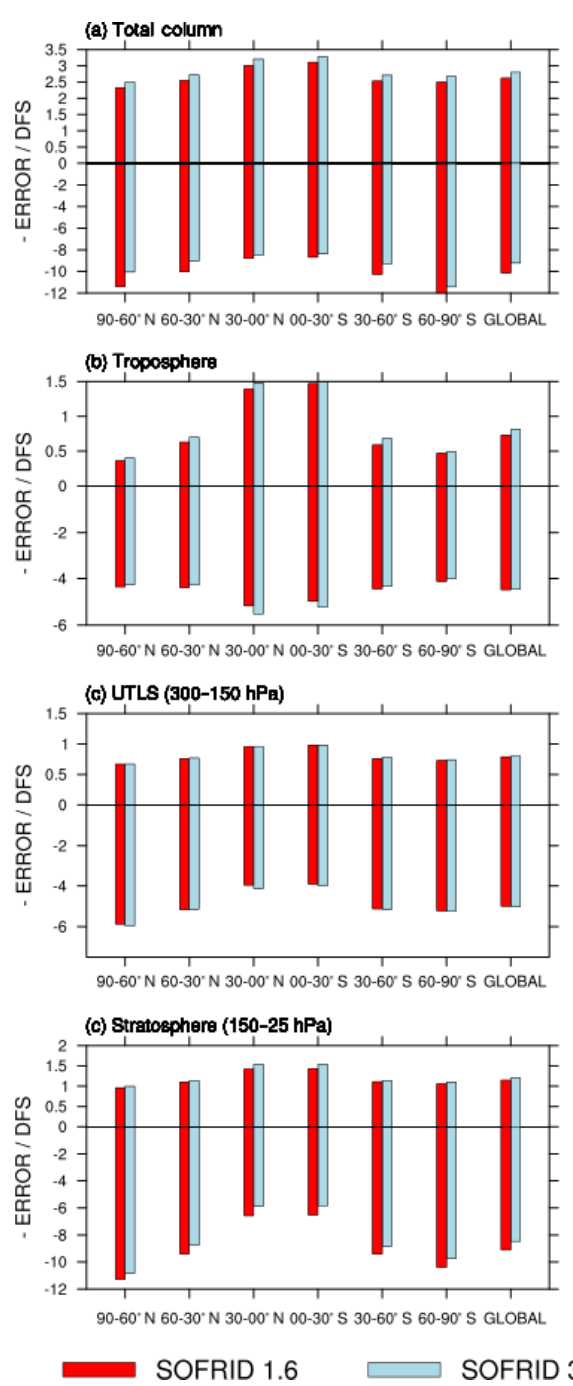
Figure 1. DFS and (–) retrieval errors in Dobson units (DU) for SOFRID-O3 v1.6 (red) and v3.5 (light blue) retrievals for (a) total column, (b) troposphere, (c) UTLS (300–150hPa) and (d) strato- sphere